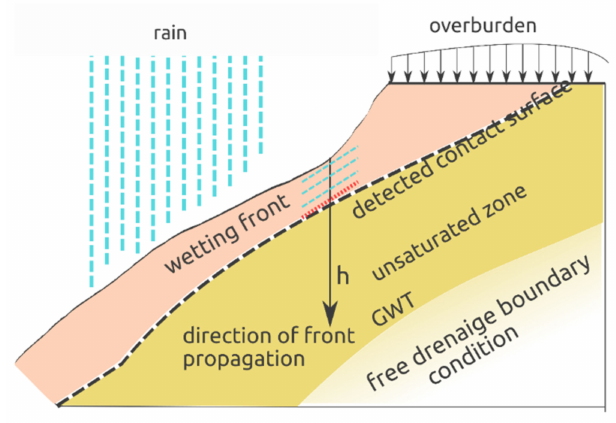
Figure 11. The task scheme (GTW—ground water